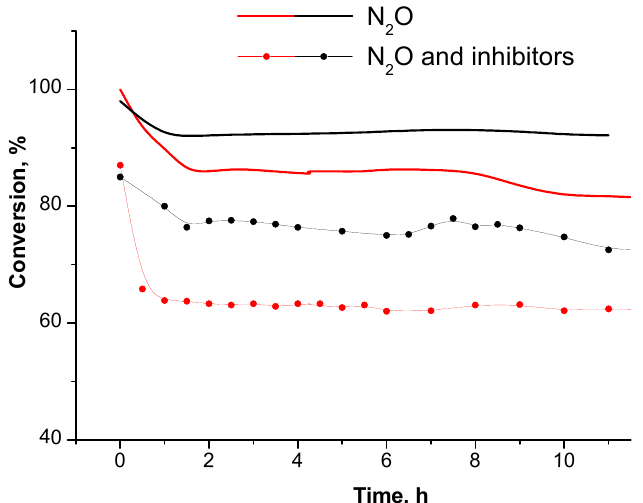
Figure 5. The N 2 O conversion during testing of the Cs/Mg-Co (black) and Cs/Ni-Co (red) (x = 0.1) samples at 300 °C.